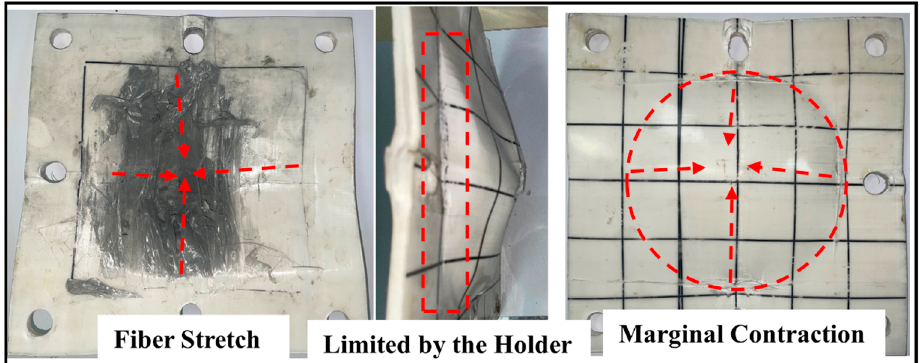
Figure 12. Marginal contraction of the UHMWPE laminate during the bulging stage.